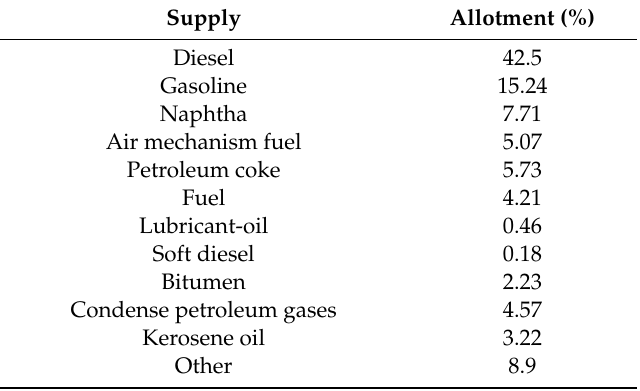
Table 5. Allocation of fossil fuel production in India during 2015–2016